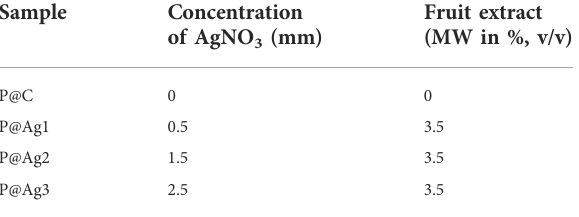
TABLE 1 Recipe for nanosilver coating over paper